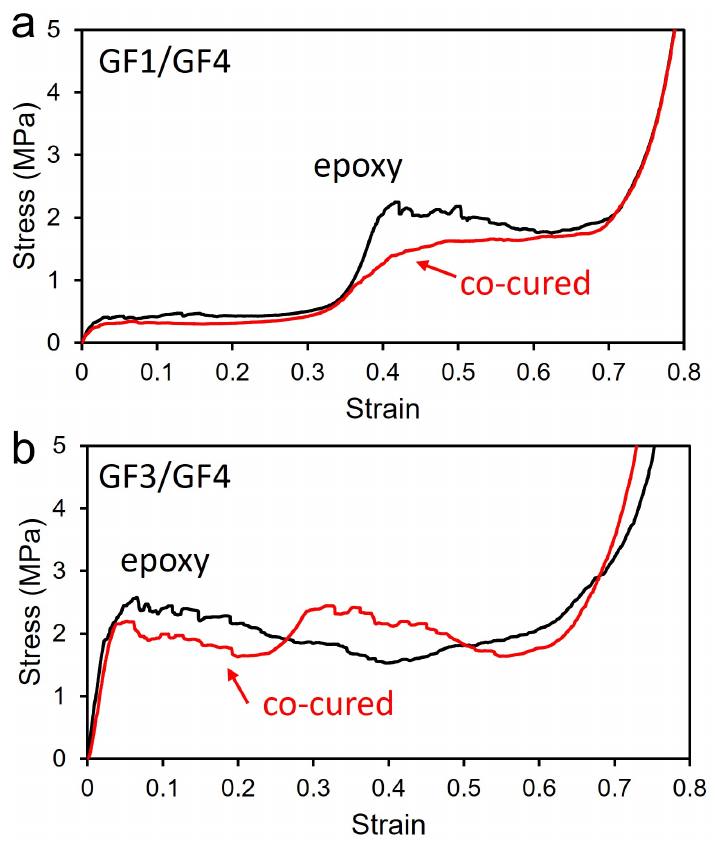
Figure 4. ( a ) Stress–strain curves of sintered bilayer foam of GF1/GF4 (red line), and epoxy-bonded bilayer foam (black line). ( b ) Stress–strain curves of sintered bilayer foam of GF3/GF4 (red line), and epoxy-bonded bilayer foam (black